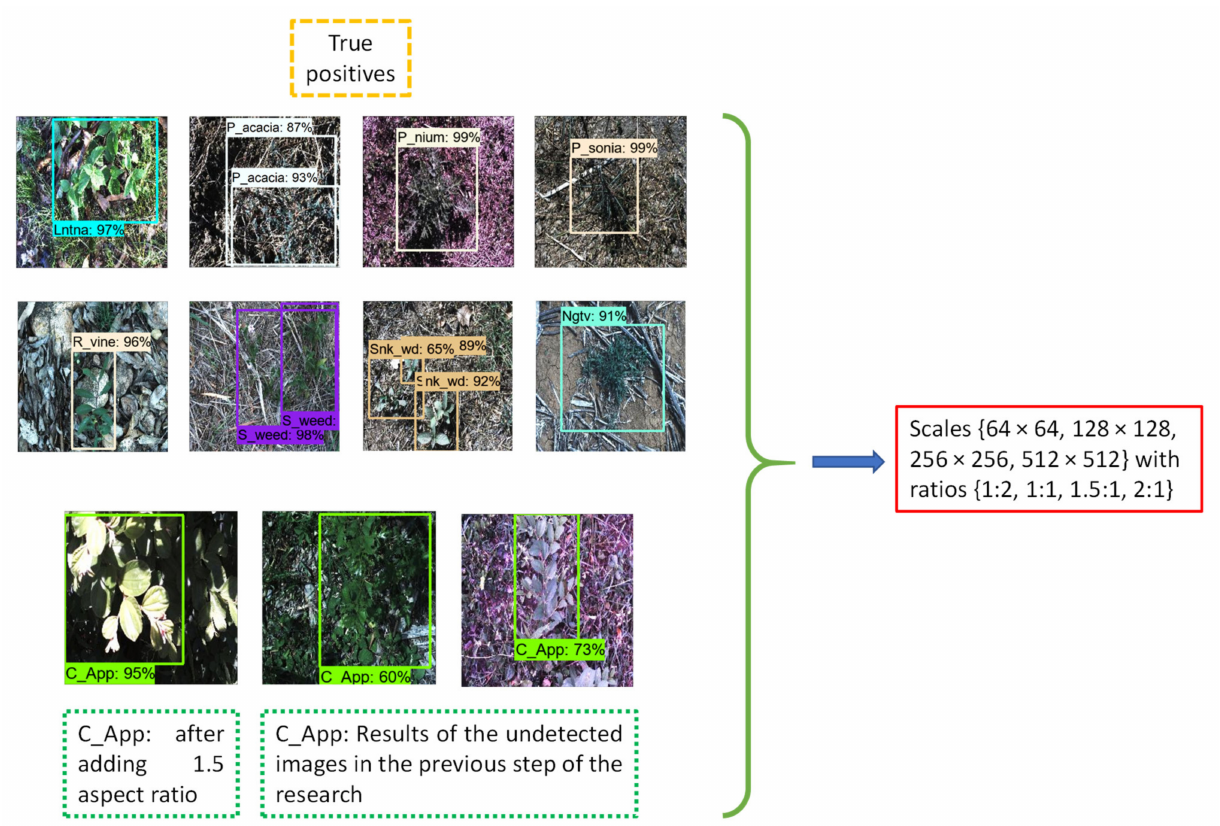
Figure 11. Detection results for all classes after the addition of a 1.5 aspect